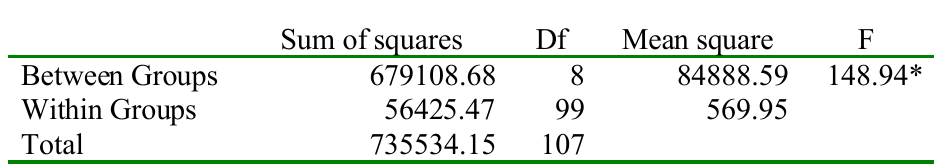
Analysis of Variance for Noun Category